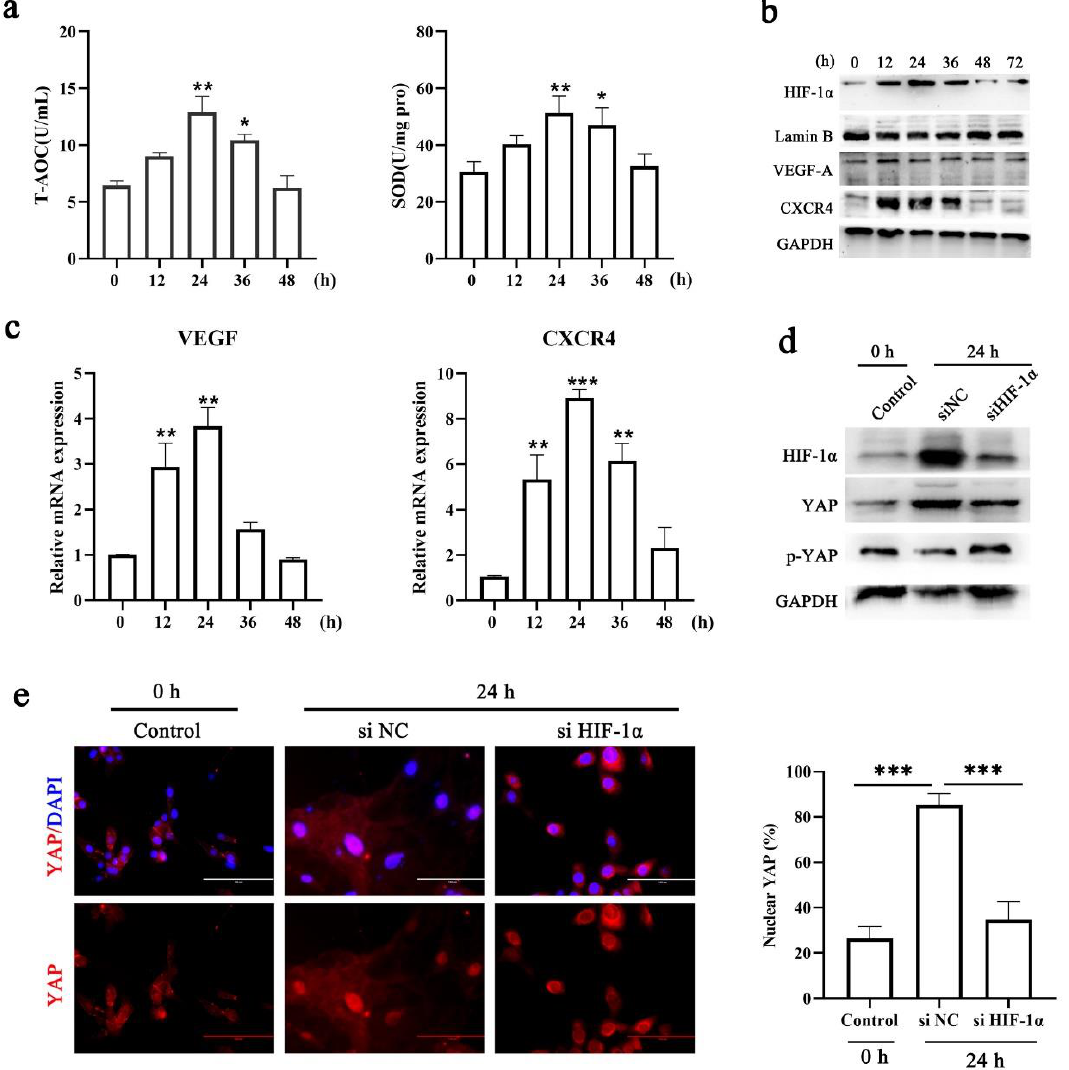
Figure 3. Hypoxia sustains HIF-1 α protein stability to activate YAP . ( a ) Analysis of the antioxidant indices T-AOC activity and SOD activity in endometrial tissue. n =3. ( b ) The protein levels of VEGF, CXCR4, and HIF-1 α were evaluated in the uterus by Western blotting. n = 3. ( c ) Comparison of the mRNA expression levels of VEGF and CXCR4 in isolated mouse endometrial tissue during menstruation. n = 3. ( d ) Lysates of ESCs transfected with siYAP and siNC after withdrawing P4 were analyzed for the presence of the indicated proteins. n = 3. ( e ) Confocal immunofluorescence images (left, n = 2) and quantification of nuclear and cytoplasmic subcellular localization (right, n = 15) of YAP in decidualized cells transfected with siYAP. Scale bar: 100 µ m. The data are presented as the mean ± SEM. Experiments were repeated n times with duplicate biological replicates. * p < 0.05, ** p < 0.01; *** p <